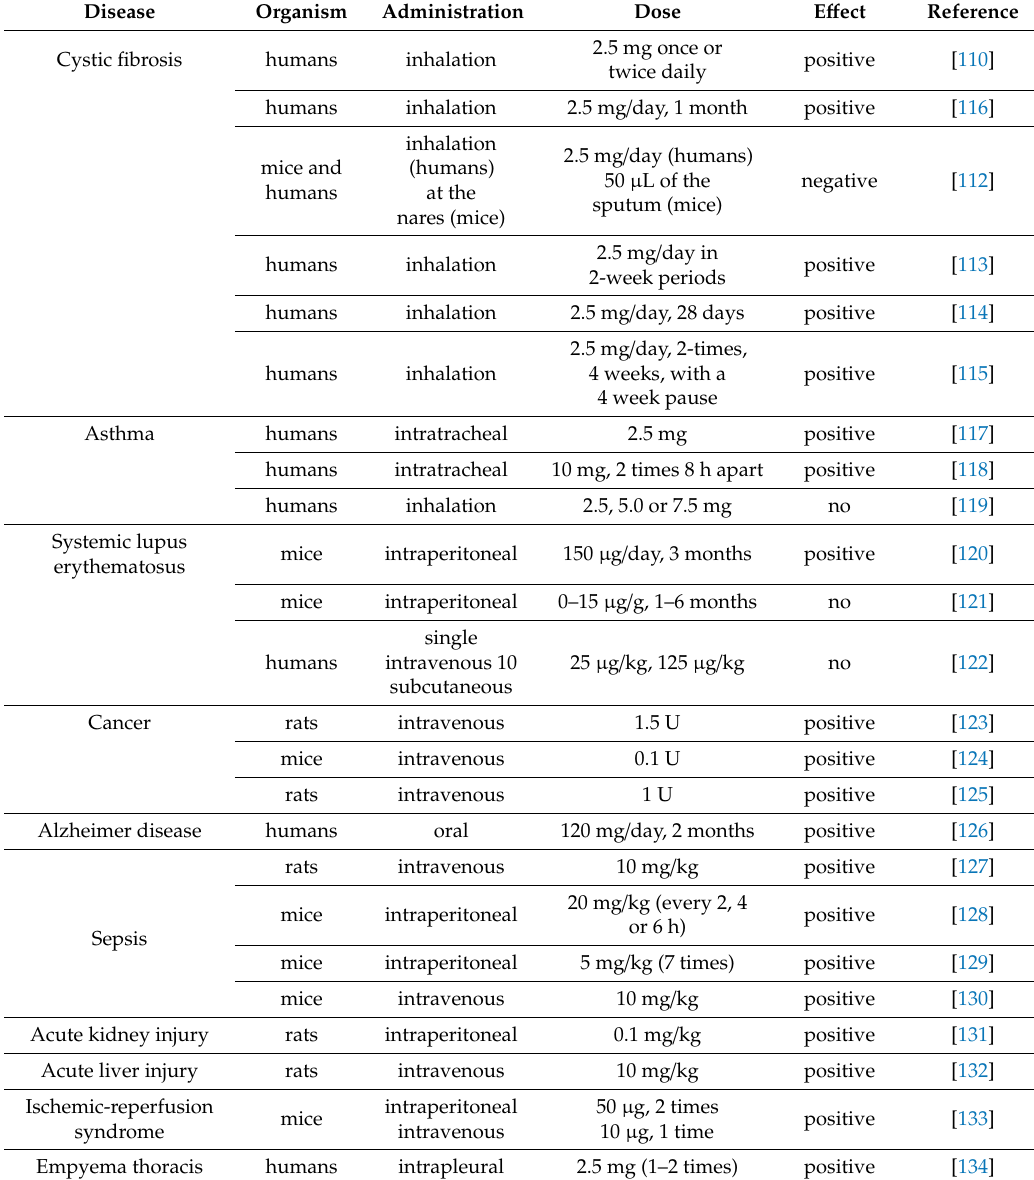
Table 2. E ff ect of the DNase treatment in various